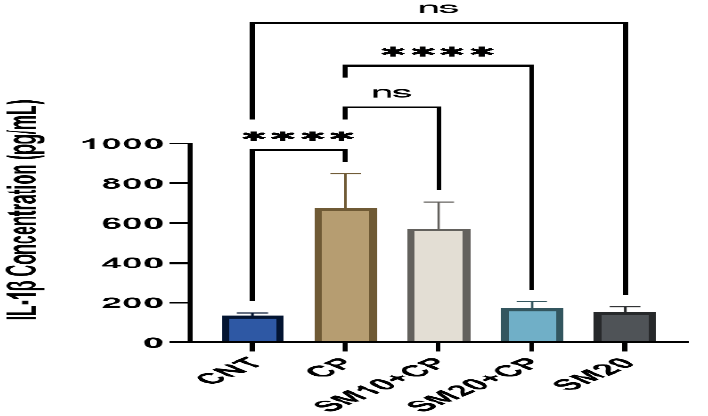
Figure 1. Protective effects of SM on renal inflammatory cytokine (IL-1 β ) level against CP-induced nephrotoxicity. Value denoted in mean ± SD (n = 6). **** p < 0.0001 vs. CNT, **** p < 0.0001 vs. CP and ns p > 0.05 vs. CNT, ns p > 0.05 SM10 vs.